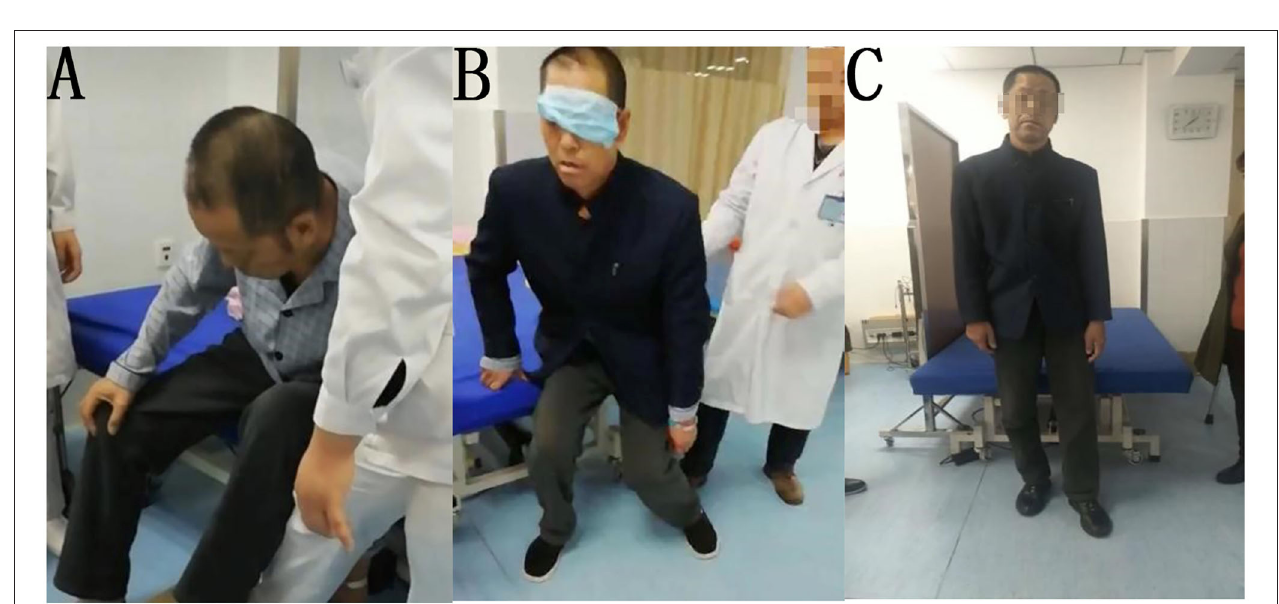
FIGURE 3 | (A) Before treatment, (B) during treatment, (C) after treatment.